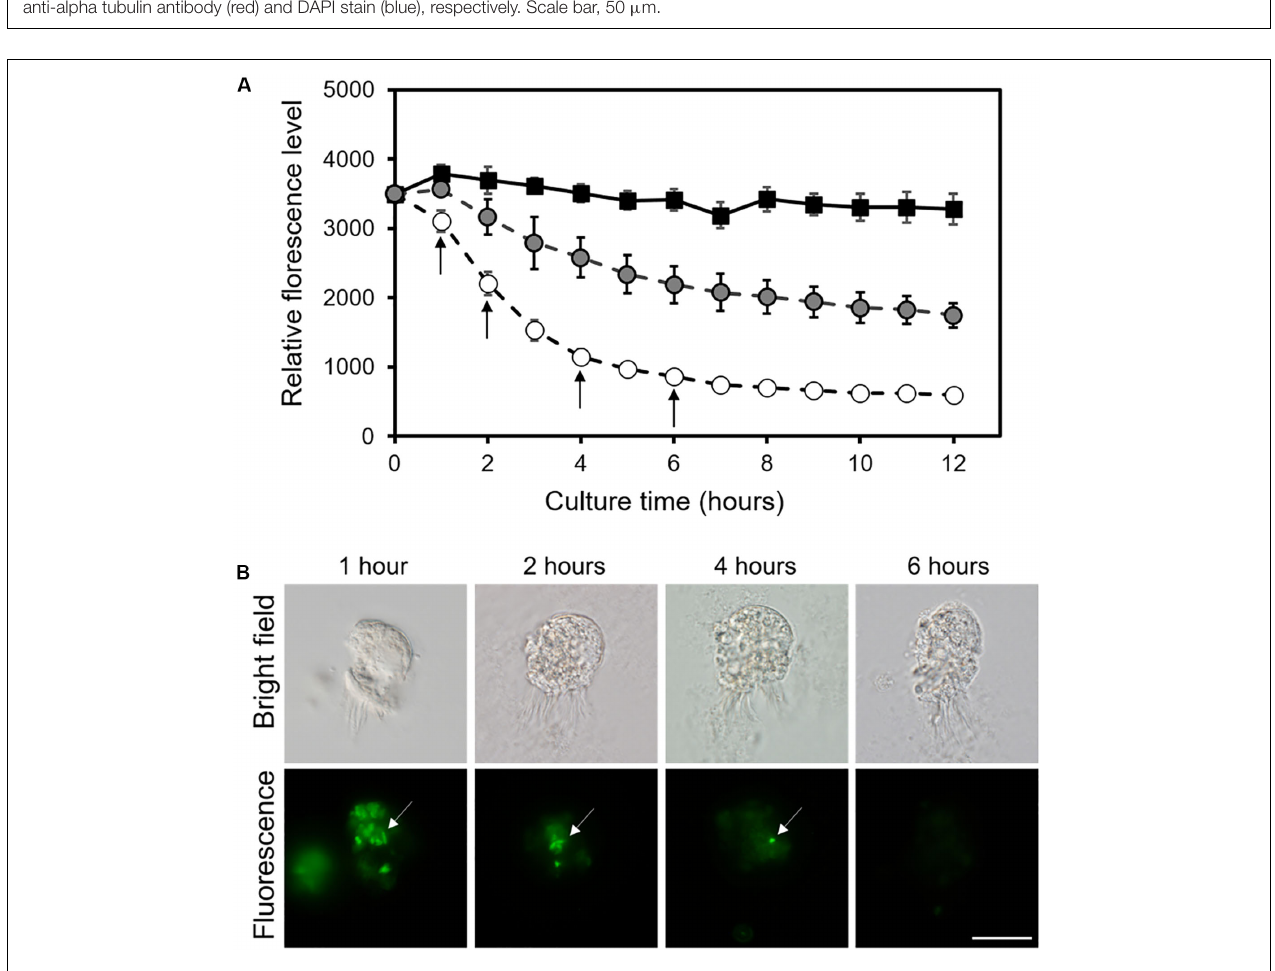
FIGURE 5 | The intensity and localization of the fluorescence from E . coli pET-EGFP strain after its feeding to Strombidium spp. NTOU1. (A) The fluorescent intensity of the E . coli pET-EGFP strain alone (black square) and E. coli with incubation with 50-cell (gray circle) or 100-cell (white circle) of ciliates at different time points. The error bar represents the SD of the average from three independent experiments. The black arrow indicates the time point for fluorescent microscopy observation. (B) Localization of fluorescent bacteria in the ciliate cell after 1, 2, 4, and 6 h of incubation. The white arrow indicates the food vacuole of Strombidium sp. NTOU1. Scale bar, 50 µ